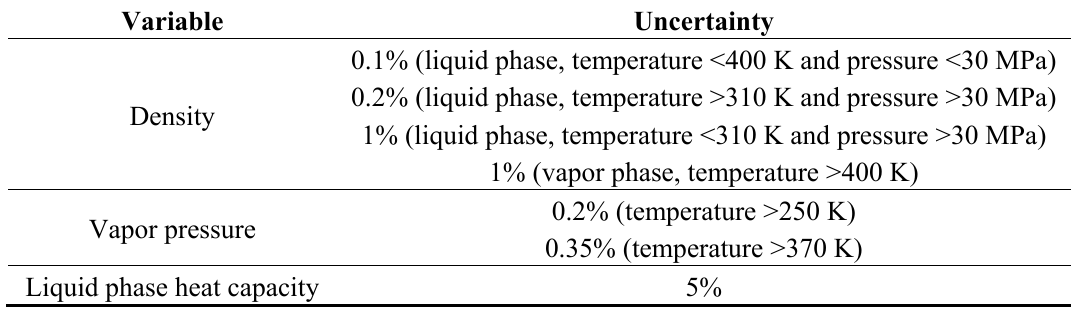
Table 7. Uncertainty for R245fa fundamental equation of state